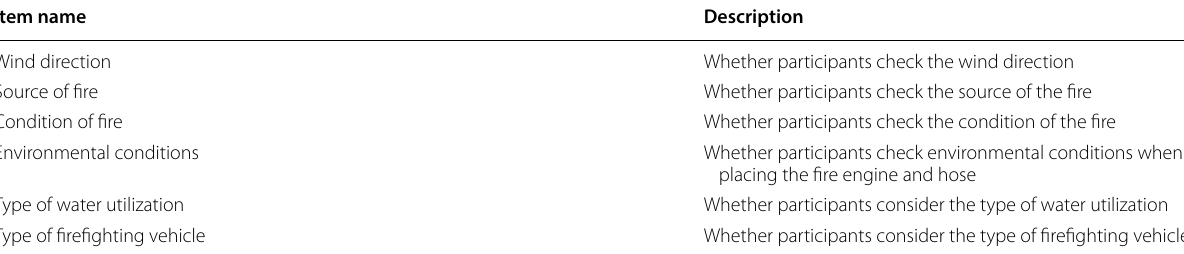
Table 3 Evaluation items for deciding on the water discharge